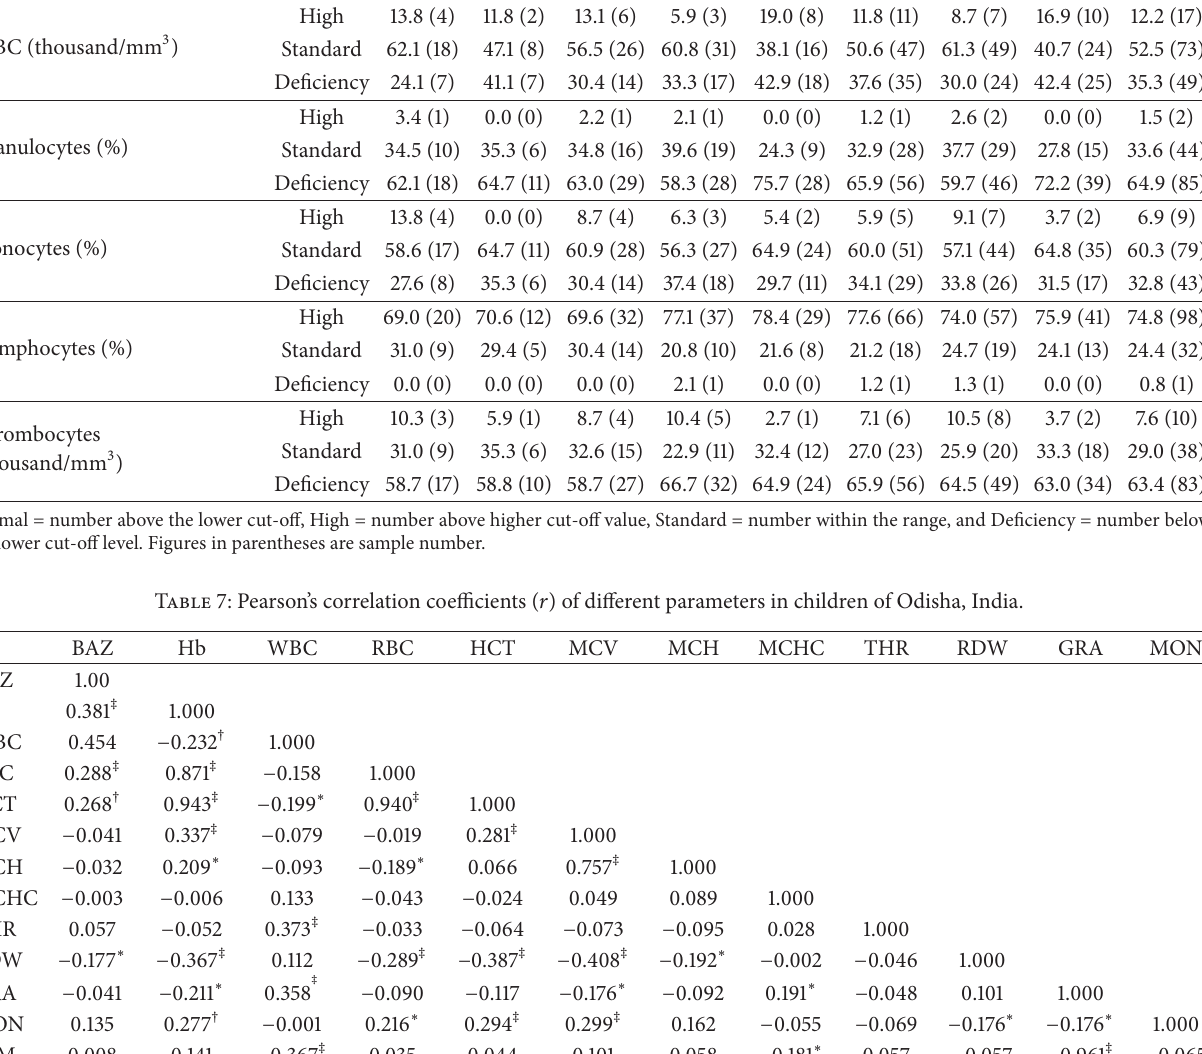
Table 6: Distribution of hematological (white blood cell) indicators by age group and sex among children in Odisha, India. Parameter